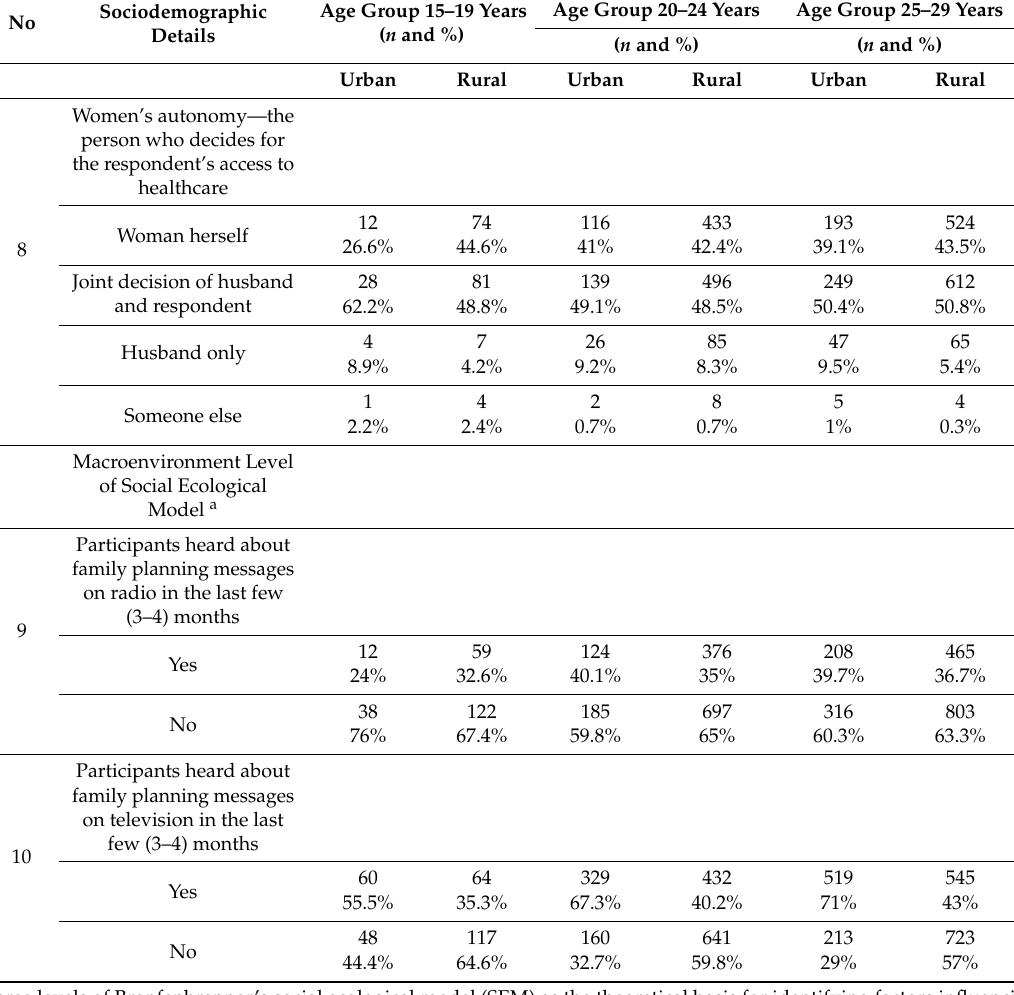
Table 2. Multiple logistic regression analyses model for factors influencing unintended pregnancy in sexually active, single, in union or married Cambodian females 15–29 years old (countrywide model).